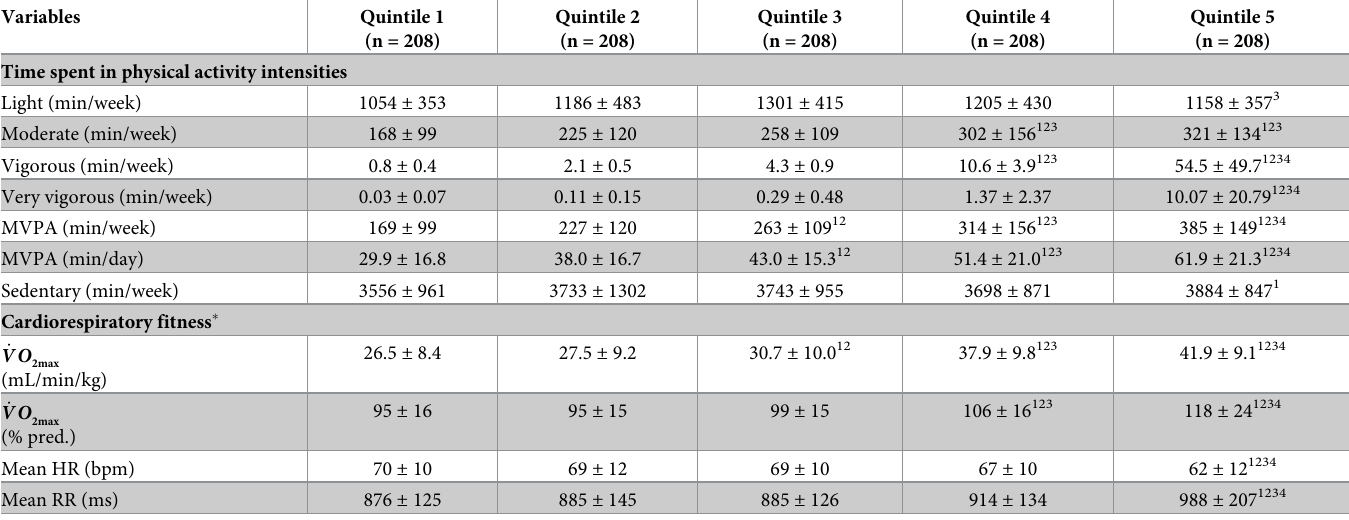
Table 2. Physical activity and fitness according to the quintiles of very vigorous physical